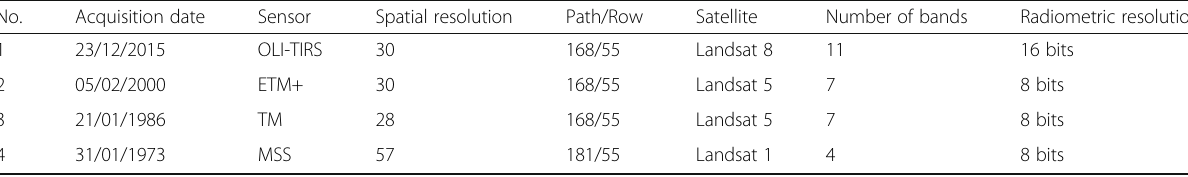
Table 7 Satellite imagery used for the multi-temporal change detection in Sidama, South Ethiopia